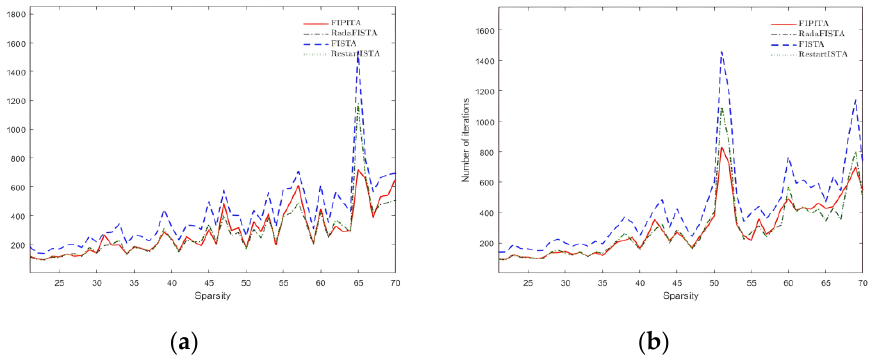
Figure 9. Required number of iterations under different sparsity. ( a ) Maximum number of iterations of Hadamard matrix; ( b ) maximum number of iterations of Gaussian matrix.